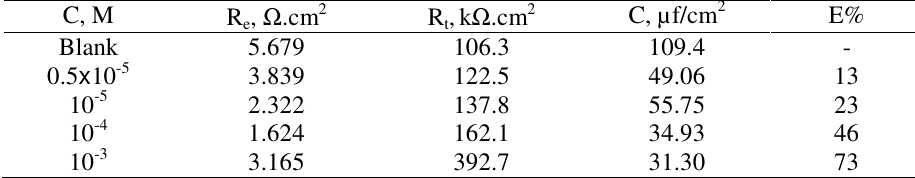
Table 3. Test results of impedance of C-steel in the medium 0.5 M HCl in the absence and the presence of the inhibitor at various concentrations